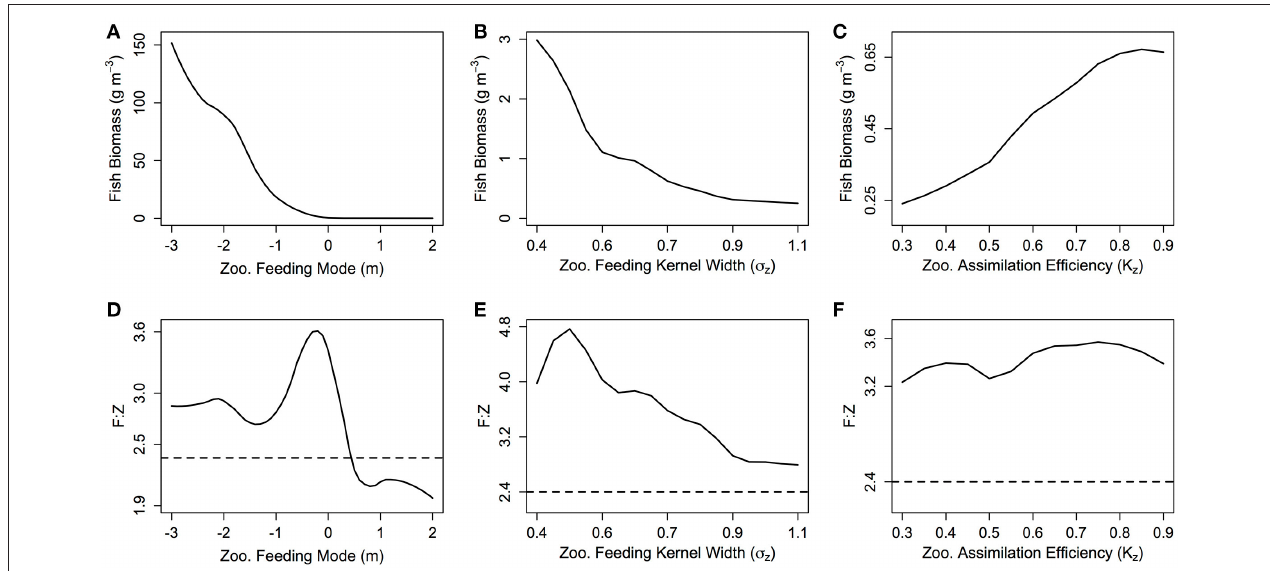
FIGURE 4 | (A–C) The total fish community biomass (g m − 3 ) and (D–F) the fish to zooplankton biomass ratio (F:Z) for different values of zooplankton feeding mode ( m ) , feeding kernel width ( σ z ) and assimilation efficiency (K z ). In each plot, the other feeding parameters not specified are held constant at m 0.7. The dashed line in (D–F) indicates the F:Z in the base model, where the zooplankton community are parameterized as fish.